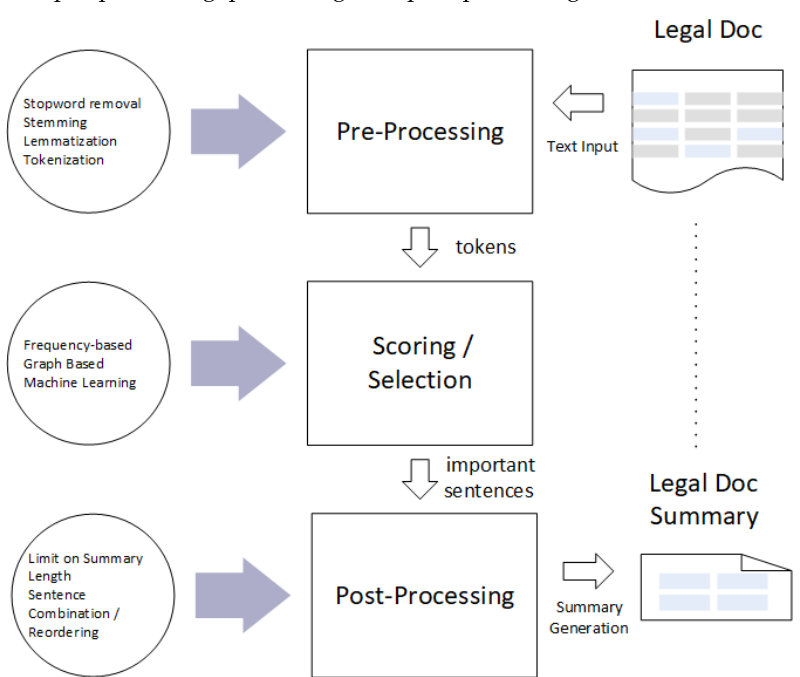
Figure 3. A general workflow of an extractive text summarization system. A combination of tech- niques/heuristics may be applied to the text at each step, to identify the most-important information from the original text and present it in a concise and readable